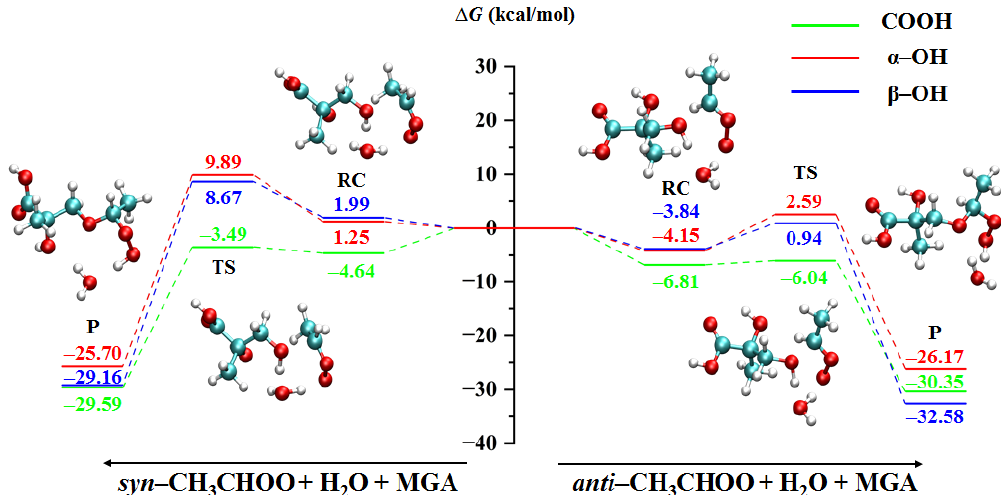
Figure 3. The minimum energy pathway for the CH 3 CHOO + H 2 O + MGA reactions (RC: reaction complex, TS: transition state, P: product).